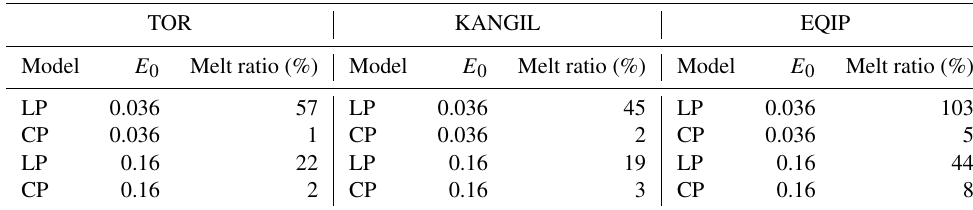
Table 4. Simulated cumulative melt rate (%) of empirical estimated cumulative melt rate for different entrainment rates for three West Greenland glaciers. TOR